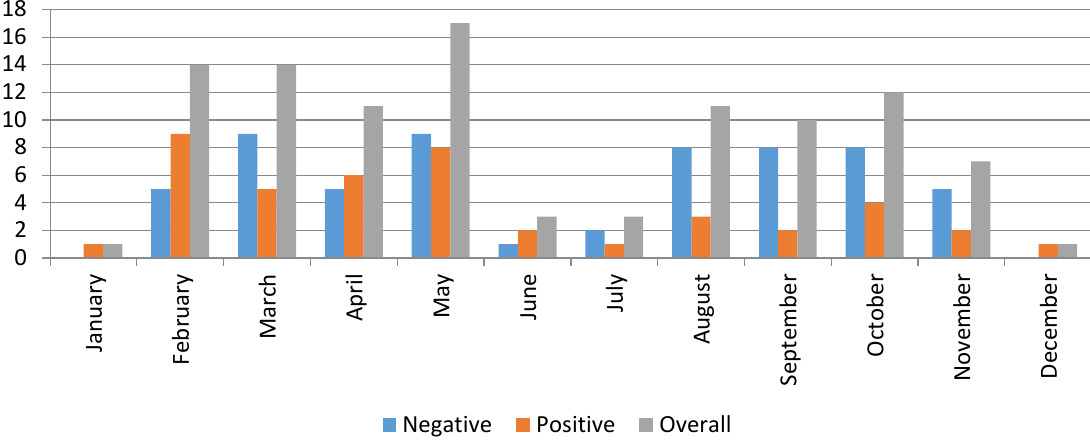
Figure 10. Monthly seasonality in overreactions frequency: case of PFTS Index